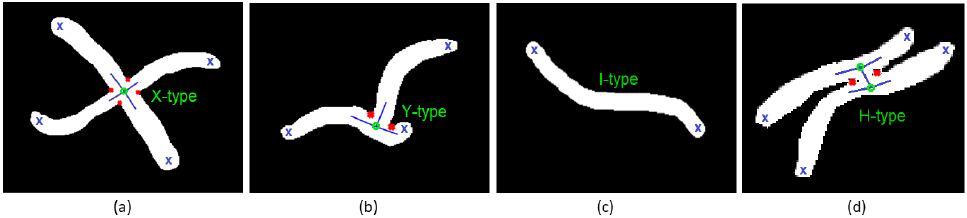
Figure 3. The common vertex types: ( a ) X -type, ( b ) Y -type, ( c ) I -type, and ( d ) H -type; the green markers represent the branching points ( bp ), the blue lines represent slope lines of the edge starting from a vertex (branching point), the red markers represent the corner points within cr radius, and the blue markers ( × ) represent endpoints of the